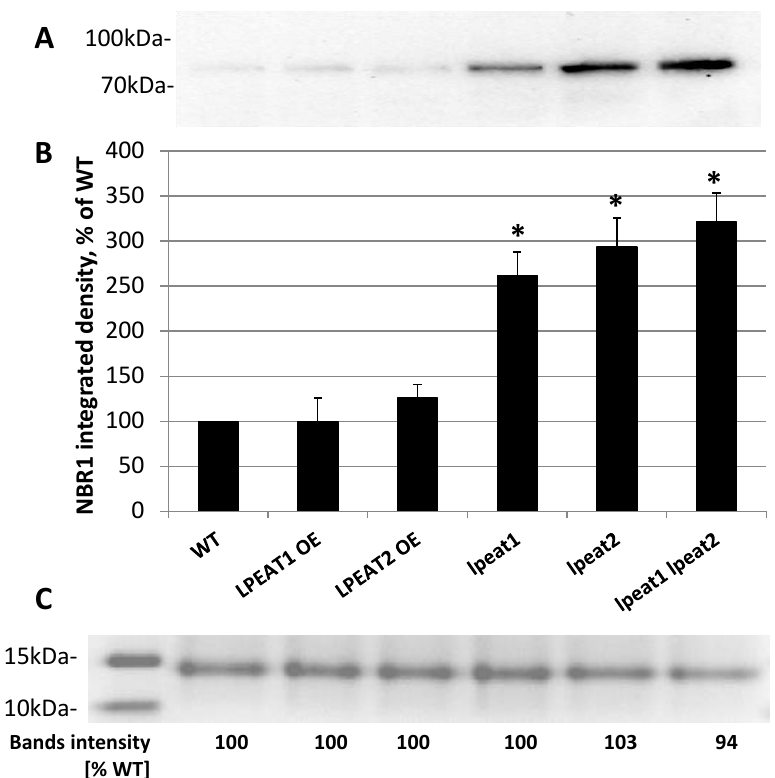
Figure 4. ( A ) NBR1-selected western blot analysis of the total protein extracts from leaves (0 DAF) of wild-type Arabidop- sis (Col-0) and LPEAT1 and LPEAT2 overexpressors, lpeat1 and lpeat2 single mutants and lpeat1 lpeat2 double mutant grown in soil under standard conditions. The blot was incubated with polyclonal antibodies against AtNBR1 protein. Equal amounts of protein (30 µg) were loaded and separated on NuPAGE 4 – 12% Bis-Tris-Gel. ( B ) NBR1 band average intensity (means ± SD) from 3 to 6 independent experiments as a percentage ofWT (wild type). Asterisk indicates signifi- cant difference compared with LPEAT1 OE (overexpressor) in “mean difference two sided test” at α = 0.05. ( C ) Fragment of selected gel with stained protein bands localiz ed between 15 and 10 kDa and “Image Lab 6.01” analyses of the intensity of these bonds.